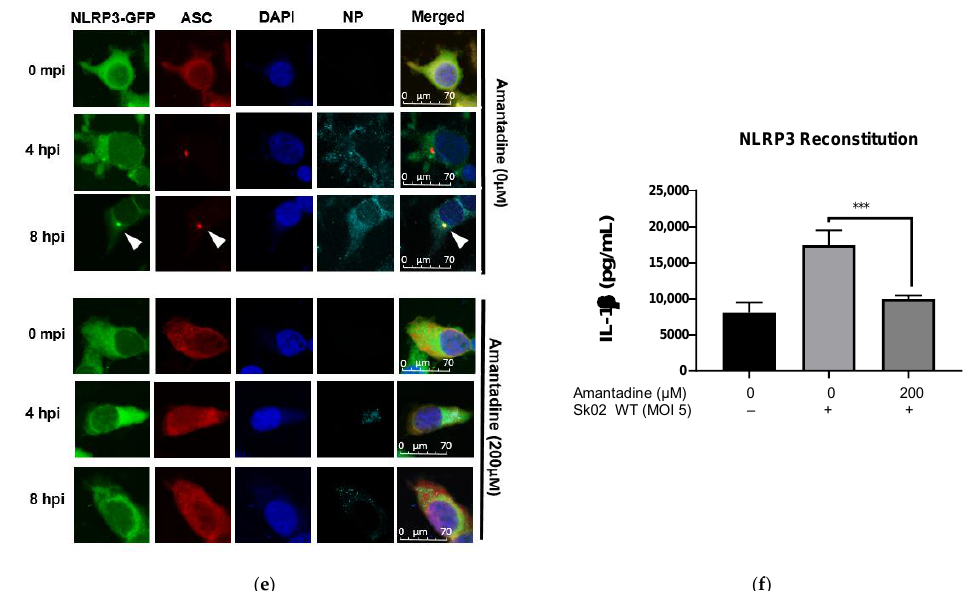
Figure 3. M2 Protein influences dTGN formation before NLRP3 recruitment. HEK293T cells were transfected with Flag-NLRP3 for 48 h before being mock infected ( a ) or infected with Hf09 WT at MOI of 5 for 12 h ( b ). The cells were harvested and fractionated to isolate the light membrane fraction containing TGN. The fractions were then subjected to Western blot and probed for NLRP3, TGN, and M2. The cell fraction was also subjected to a native PAGE gel to test the presence of NLRP3 oligomers (top panels). HeLa cells expressing NLRP3-GFP ( c ) or GFP ( d ) were treated with Amantadine (200 µ M) for 1 hr before being infected with Hf09 (MOI of 10). The cells were subjected to immunofluorescent microscopy for NLRP3 (green), TGN (red), IAV (cyan), and nucleus (blue). Scale bar, 25 µ m ( e ) Cells expressing NLRP3-GFP were transfected with ASC-Myc for 12 h. The cells were then infected with Sk02 WT at an MOI of 10 in the presence or absence of Amantadine (200 µ M). The cells were fixed at indicated time points and were subjected to immunofluorescent microscopy for NLRP3 (green), ASC (red), NP (cyan), and nucleus (blue). Scale bar, 70 µ m; white arrows indicate ASC speck. ( f ) HEK293T was transfected with the various components of the NLRP3 inflammasome namely, NLRP3, ASC, pro-caspase-1, and pro-1L-1 β , and incubated for 12 h. The media was then changed to basal DMEM containing 200 µ M Amantadine and incubated for 1 hr before being infected with Sk02 WT (MOI of 5). The cell-free supernatant was harvested at 12 h.p.i. and the level of mature IL-1 β released was measured by IL-1 β ELISA ( t -test, *** p =